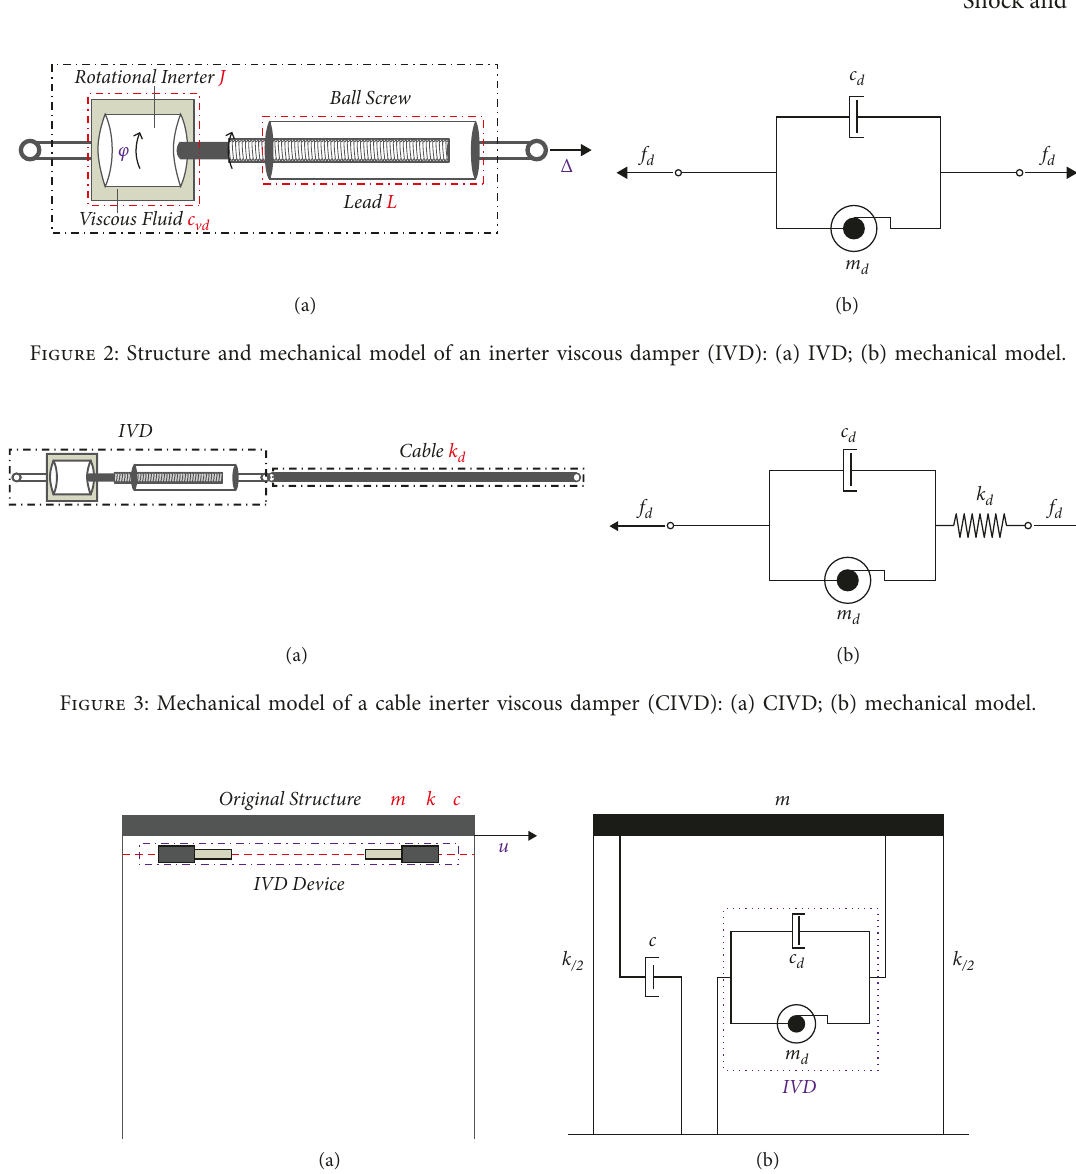
Figure 4: Layout and mechanical model of a SDOF with inerter viscous damper: (a) layout; (b) mechanical model.